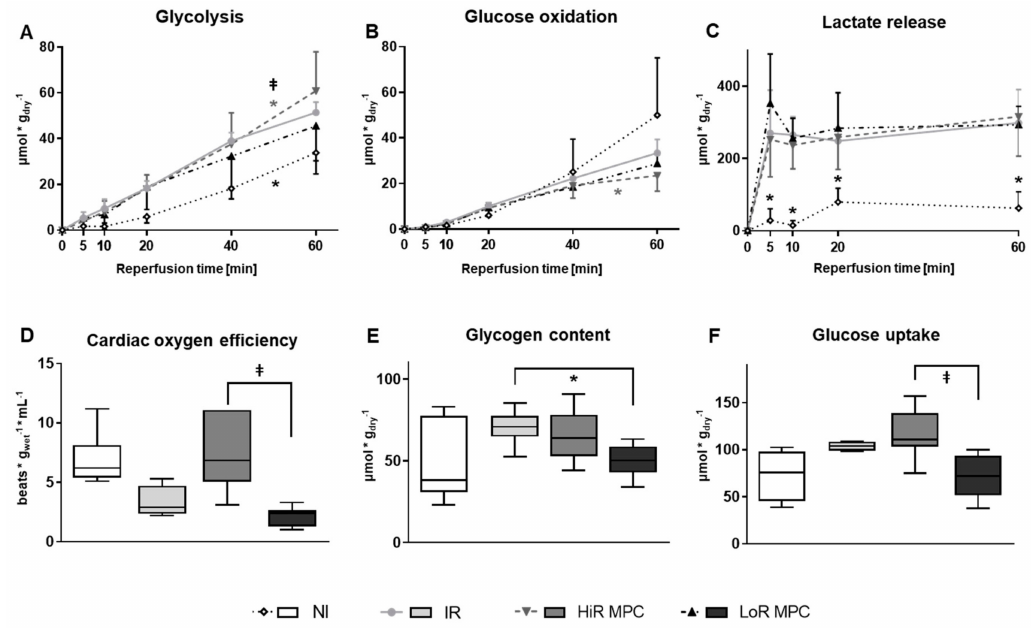
Figure 3. Post-ischemic metabolic recovery. ( A ) Rates of glycolysis; ( B ) Rates of glucose oxidation; ( C ) Lactate accumulation (net change) in recirculating perfusate; ( D ) Oxygen e ffi ciency [LV work /